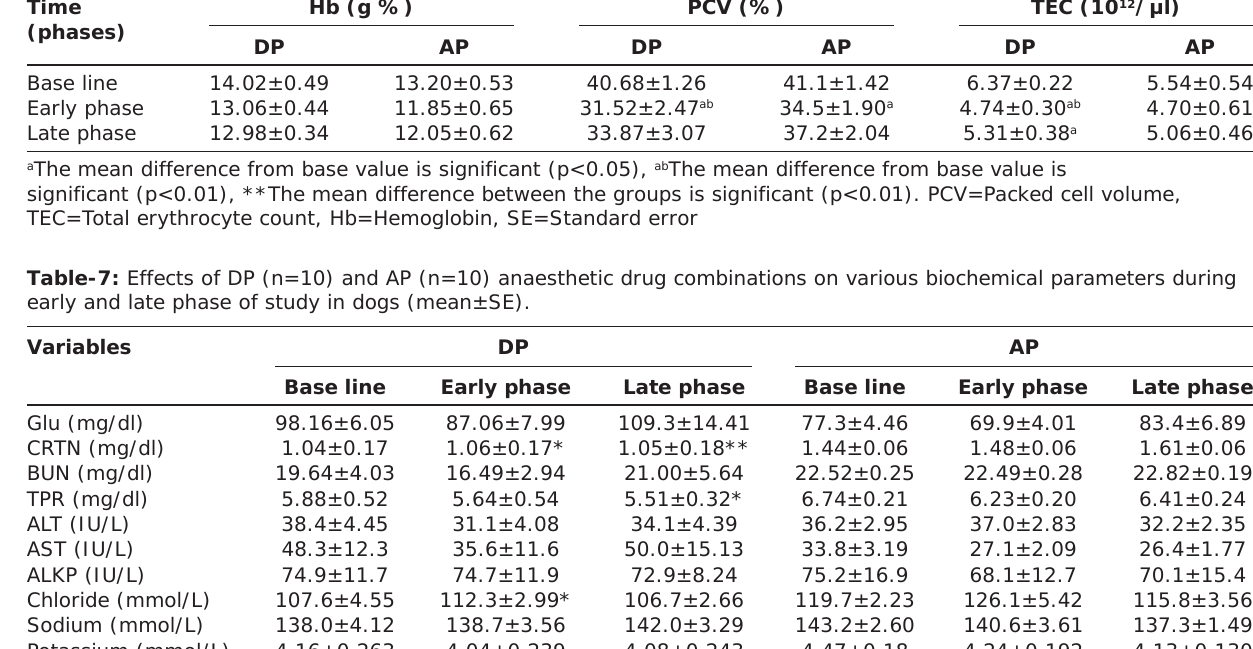
Table-6: Effects of DP (n=10) and AP (n=10) anaesthetic drug combinations on various haematological parameters during early and late phase in dogs (mean±SE). Time Hb (g %) (phases)